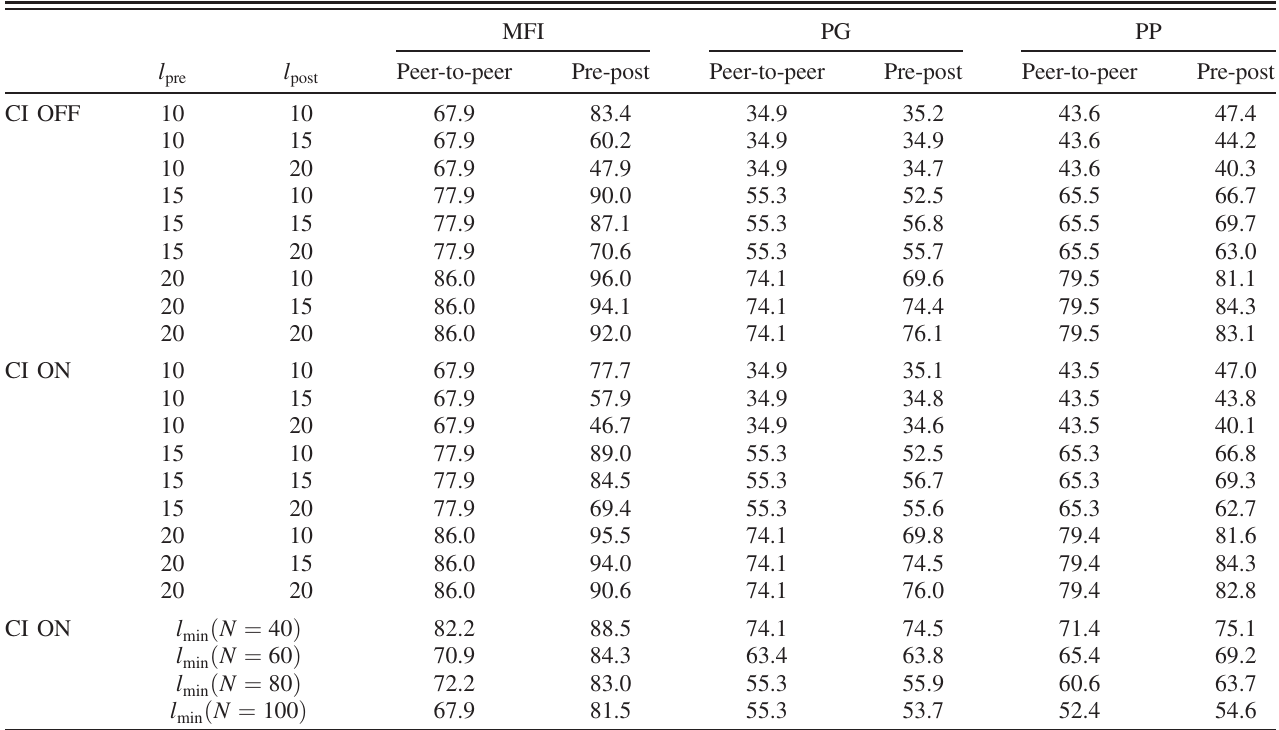
TABLE II. Pre-post overlap rate and peer-to-peer overlap rate of various test lengths for three item selection methods. In the top and middle of the table, we present the results of N ¼ 40 without and with collateral information. In the bottom of the table, we present the rates at the minimal test lengths ( l ) shown in Table I for each class size ( N ¼ 40 , 60, 80, 100). min